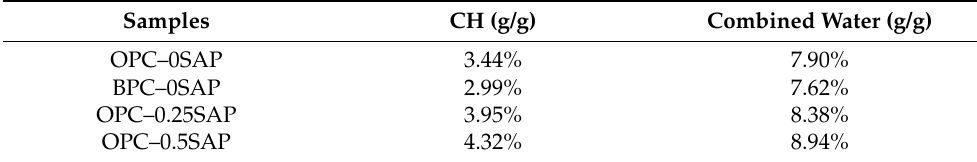
Table 5. The mass of calcium hydroxide (CH) and combined water